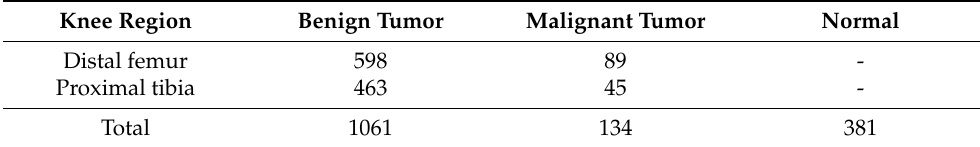
Table 1. Chonnam National University Hospital (CNUH) dataset. Knee Region Benign Tumor Malignant Tumor Normal Distal